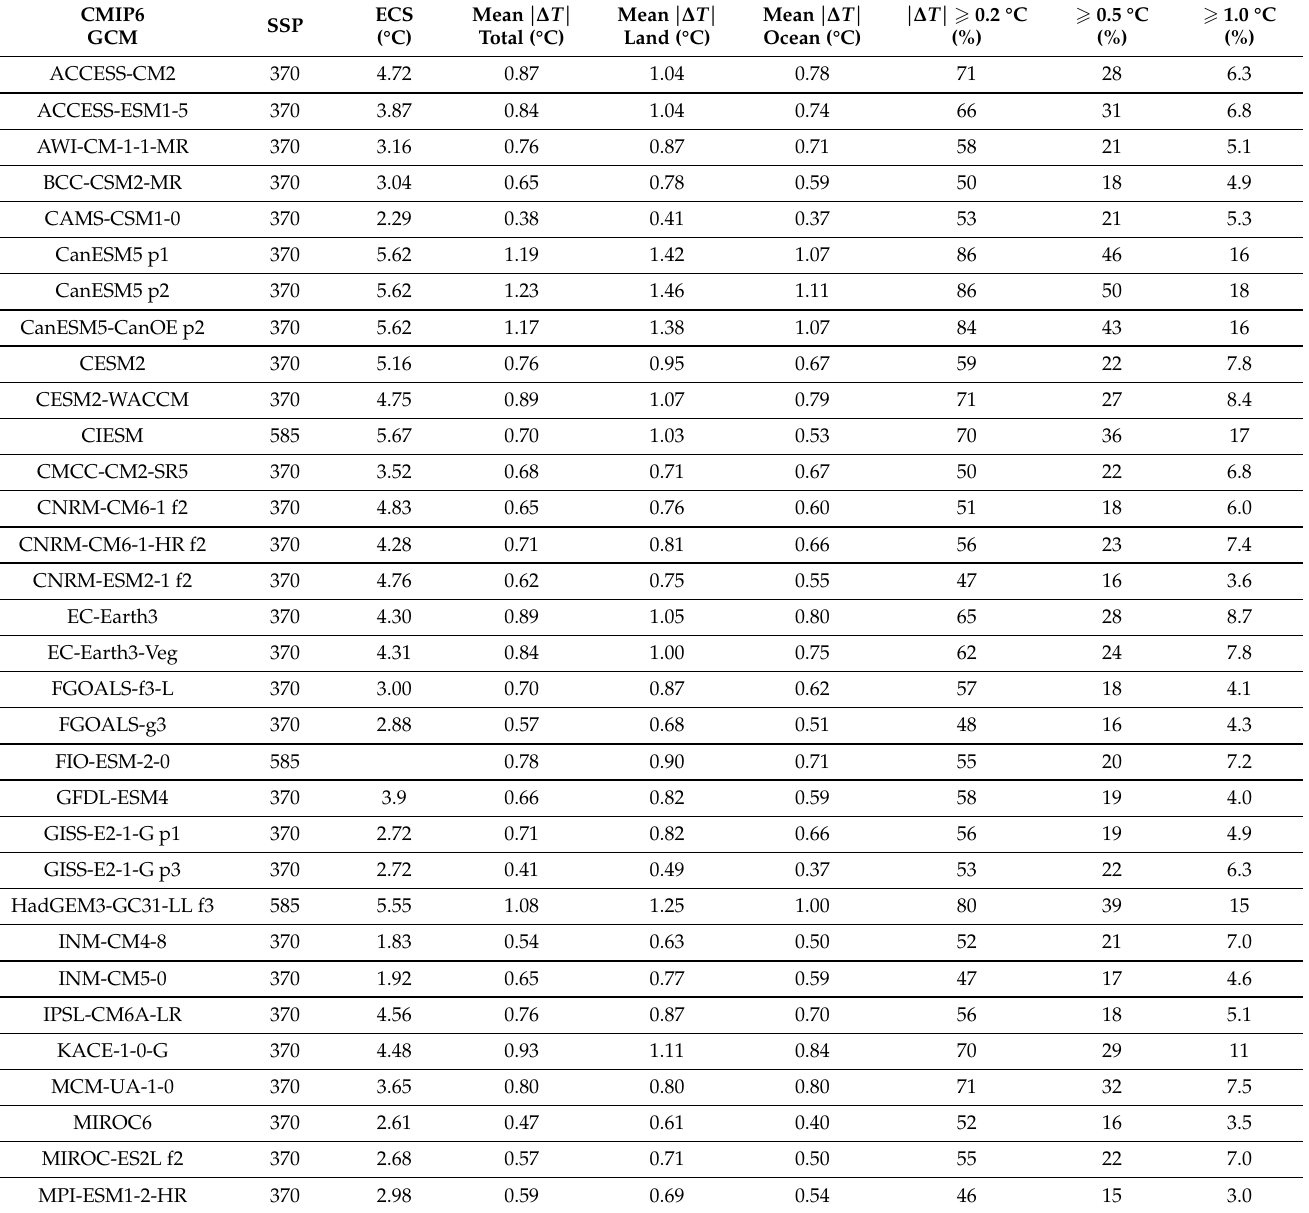
Table 1. The CMIP6 GCMs herein studied using the listed SSP simulation, the mean warming from 1980–1990 and 2011–2021 (over the total surface, land and ocean), and their performance estimated by the percentage of the world area where they disagree with the ERA5-T2m record by | ∆ T | (cid:62) 0.2 °C, | ∆ T | (cid:62) 0.5 °C and | ∆ T | (cid:62) 1.0 °C regarding the warming